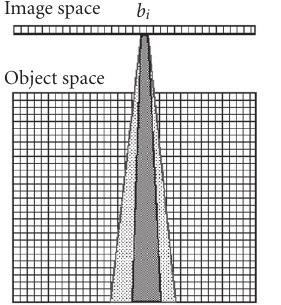
Figure 3: The original backprojection cone corresponding to a pixel b i and composed of voxels